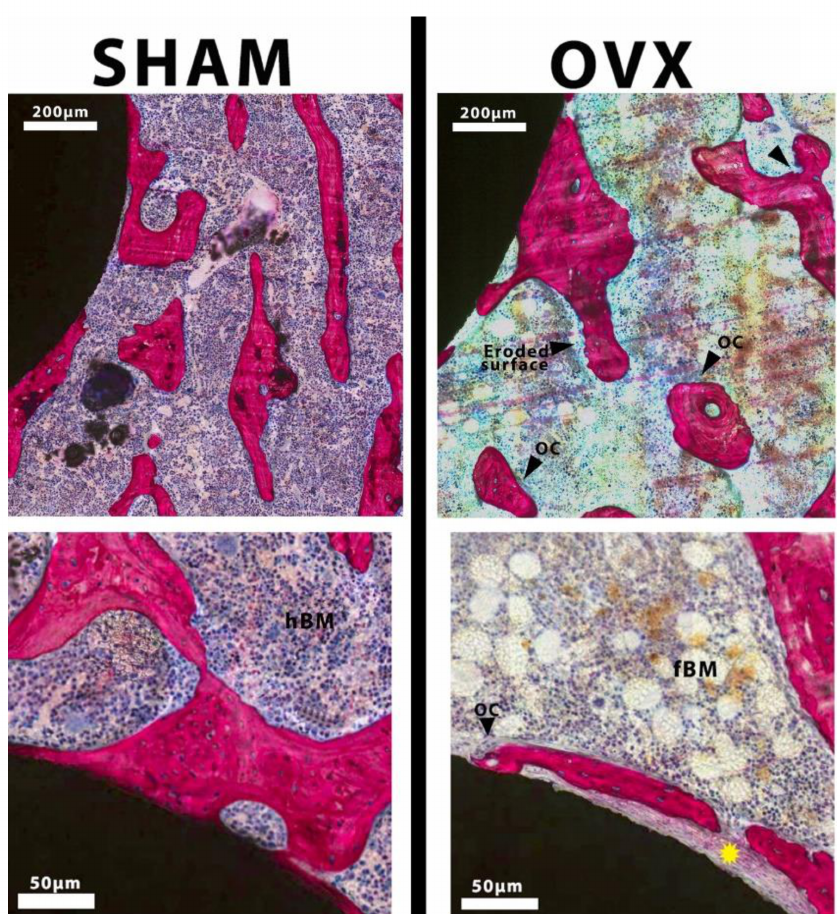
Figure 5. Representative histological images at higher magnification showing eroded bone trabeculae in OVX rats (black arrowhead). Osteoclast (OC)-like cells were present. Bone marrow in the OVX rats contained more fat cells (fBM) in comparison to the hypercellular bone marrow (hBM) in the SHAM group. In some OVX sections, a fibrous tissue layer (yellow star) was detected intervening between bone and implant surface.